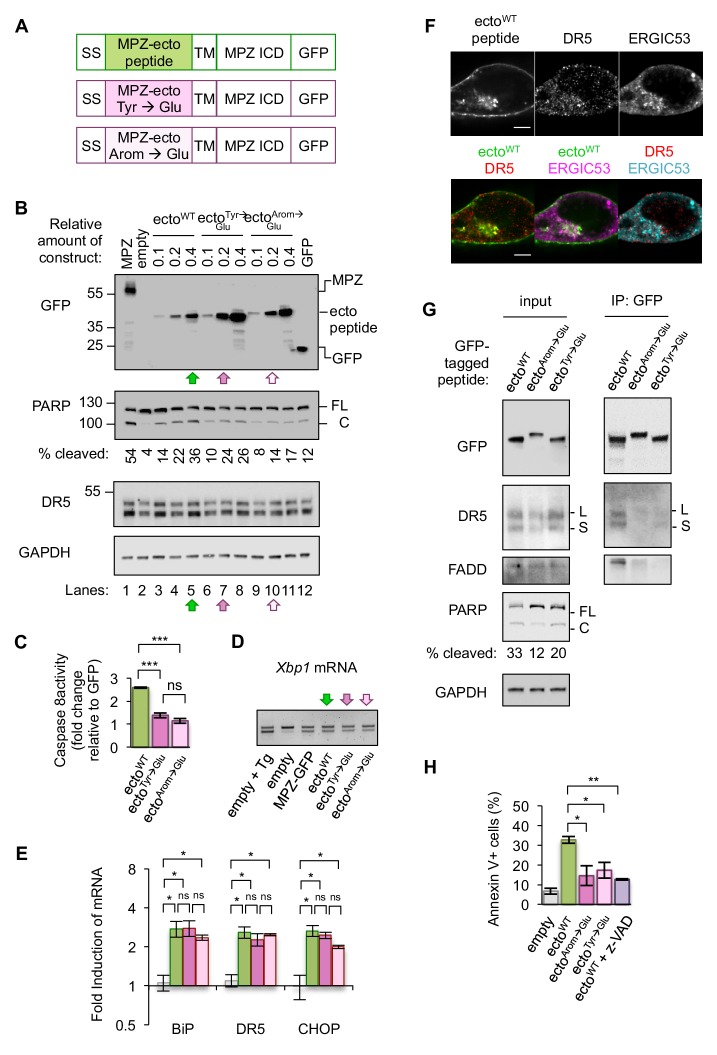
Disrupting misfolded protein binding to DR5 impairs ER stress-induced apoptosis.(A) Diagram of constructs generated to replace the MPZ ectodomain with the minimal DR5-binding MPZ-ecto peptide (green), the peptide harboring Tyr → Glu mutations (magenta), or the peptide with all aromatic residues (Arom) mutated to Glu (light pink). SS = signal sequence of MPZ, TM = transmembrane domain, ICD = intracellular domain. (B) Western blot of HCT116 cell lysates harvested 24 hr post-transfection with 1 μg of MPZ-GFP plasmid, empty vector, or a titration of GFP-tagged MPZ-ecto peptide variants, followed by GFP alone. FL denotes full-length PARP, while C denotes cleaved PARP. The percentage of cleaved PARP was calculated as the signal of cleaved PARP divided by total PARP (FL + C). Arrows denote conditions carried forward for normalized expression levels of the ecto peptide constructs. (C) Fold change in caspase8 activity relative to GFP expression, as measured by incubation of luminescent caspase glo 8 substrate with lysates from HCT116 transfected using conditions described in Figure 4B lanes 5, 7 and 10 (error bars represent SEM of n = 3 biological replicates; *** denotes p<0.005, and ns indicates p=0.18 from unpaired t-tests with equal SD). (D) RT-PCR for unspliced and spliced forms of Xbp1 mRNA isolated from HCT116 cells transfected for 24 hr with the empty vector + / - 100 nM Tg, or with MPZ-GFP, or MPZ-ecto peptide-GFP and its mutant variants (Tyr → Glu and Arom → Glu) using conditions from Figure 4B, lanes 5, 7, and 10. (E) qPCR for reverse-transcribed transcripts harvested from HCT116 cells transfected with the constructs described in 4A, using conditions shown in Figure 4B lanes 5, 7, and 10. (n = 3 biological replicates, * denotes p<0.05 and ns = non significant). (F) Immunofluorescence for DR5 and ERGIC53 in HCT116 transfected with the MPZ-ecto peptide for 24 hr. ERGIC53 is magenta in the overlay with MPZ (green) or cyan in the overlay with DR5 (red) (scale bar = 5 μm). (G) Left: Immunoblots of HCT116 lysate inputs expressing the constructs described in 4A, where L and S mark the long and short isoforms of DR5, respectively, and where FL and C mark the full-length and cleaved fragments of PARP, respectively. The percentage of cleaved PARP is quantified as the signal of the cleaved fragment divided by total PARP (FL + C). Right: Immunoprecipitation of GFP-tagged proteins from the lysates shown in (C), where L and S denote the long and short isoforms of DR5, respectively. (H) Average percent of annexin V staining for HCT116 cells transfected as described in C) and D) from n = 3 biological replicates (error bars = SEM, * indicates p=0.026, and ** indicates p=0.003 from unpaired t-tests with equal SD). See Figure 4—figure supplement 3 for distribution of early vs late apoptotic cells.Figure 4—source data 1.Westerns and quantification of DR5 recovered on IPs.This zip archive contains tif files of the Westerns from inputs and IPs of the MPZ-ecto peptides (n = 2 biological replicates) used to quantify the percent of DR5 recovered shown in Figure 4—figure supplement 3A.Figure 4—source data 2.Caspase glo 8 measurements for MPZ-ecto peptide expression.This zip archive contains the measured luminescent units for caspase glo 8 activity shown in Figure 4C (lysates) and the coomassie gel used to normalize lysate concentration as a.tif file.Figure 4—source data 3.qPCR and statistical analysis for expression of MPZ-ecto peptides.This zip archive contains the compiled excel file for qPCR data shown in Figure 4E along with the Prism six file used to perform multiple t-tests with Holm-Sidak correction for multiple comparisons.Figure 4—source data 4.FCS files and quantification of annexin V staining for MPZ-ecto peptides.This zip archive contains FCS files from n = 3 biological replicates of HCT116 transfected with the conditions outlined in Figure 4H. The excel file contains the quantification of annexin V staining exported frow FlowJo.